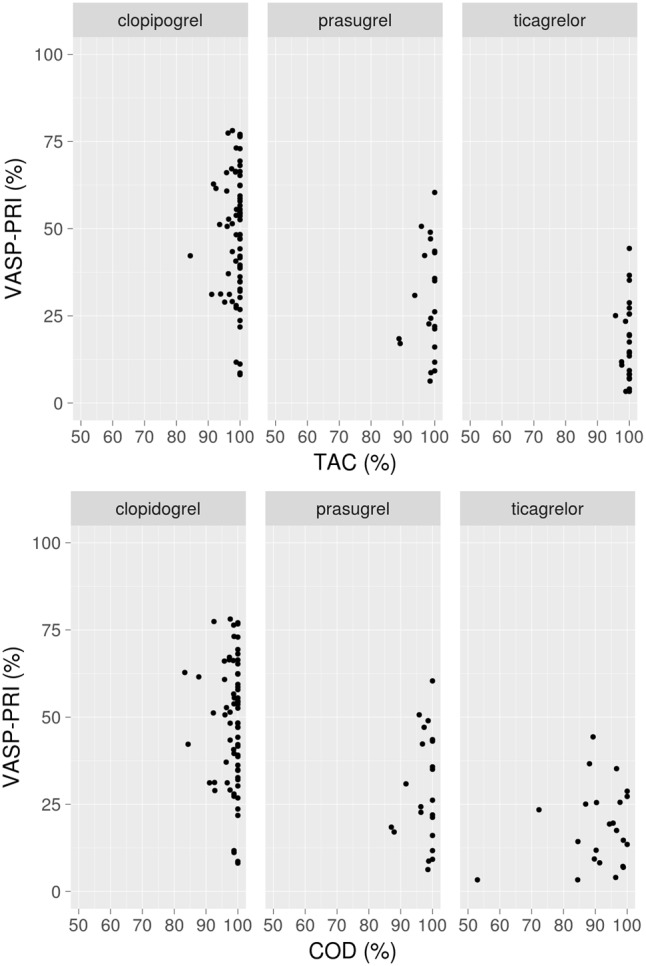
Association between VASP-PRI at 6-months and taking adherence (upper) and correct adherence (lower) in the 30 days preceding the VASP-PRI assay. VASP-PRI, vasodilator-stimulated-phosphoprotein-phosphorylation-platelet-reactivity-index.